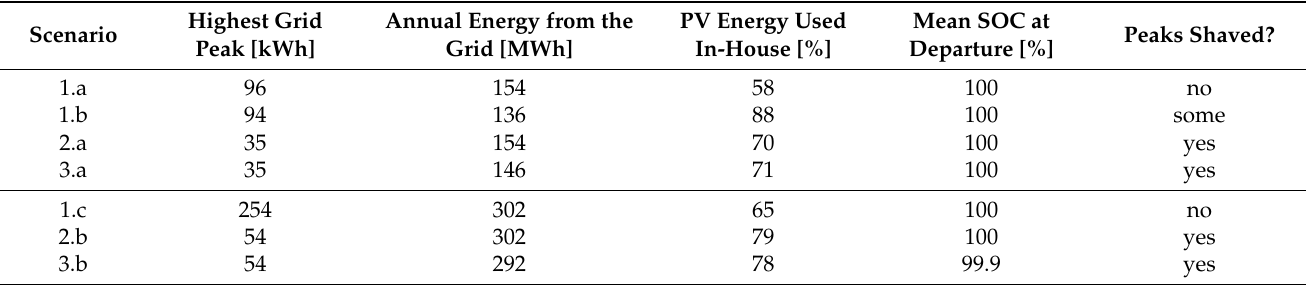
Table 5. Summary of some results from the different scenarios: current/short-term scenarios (1.a